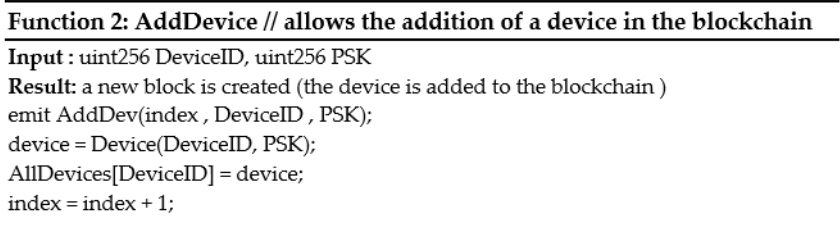
Table 1. Parameter notations and lengths .